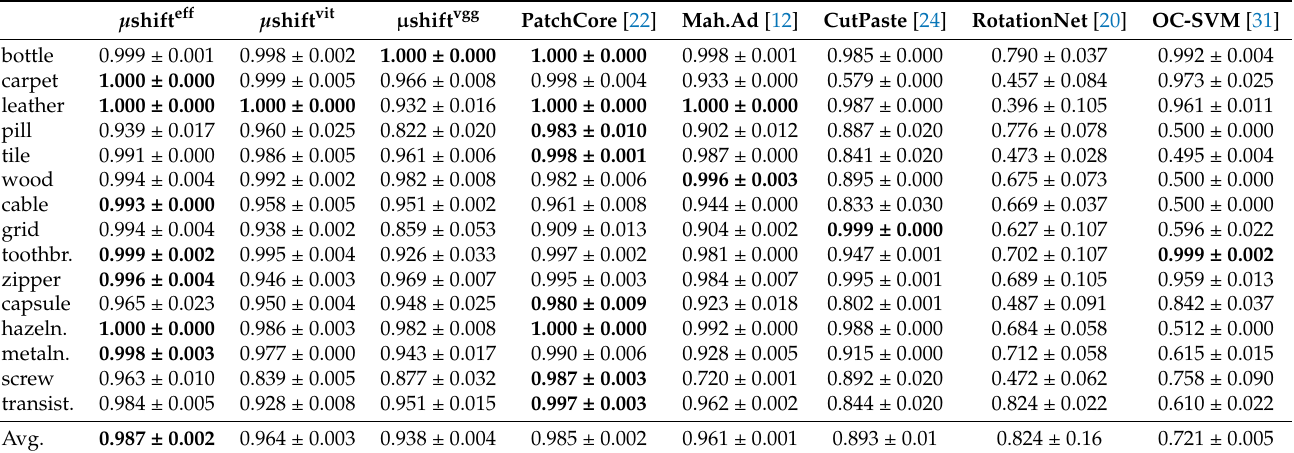
Table 3. Evaluating the detection of locally concentrated novelty on the MVTec dataset using five- fold